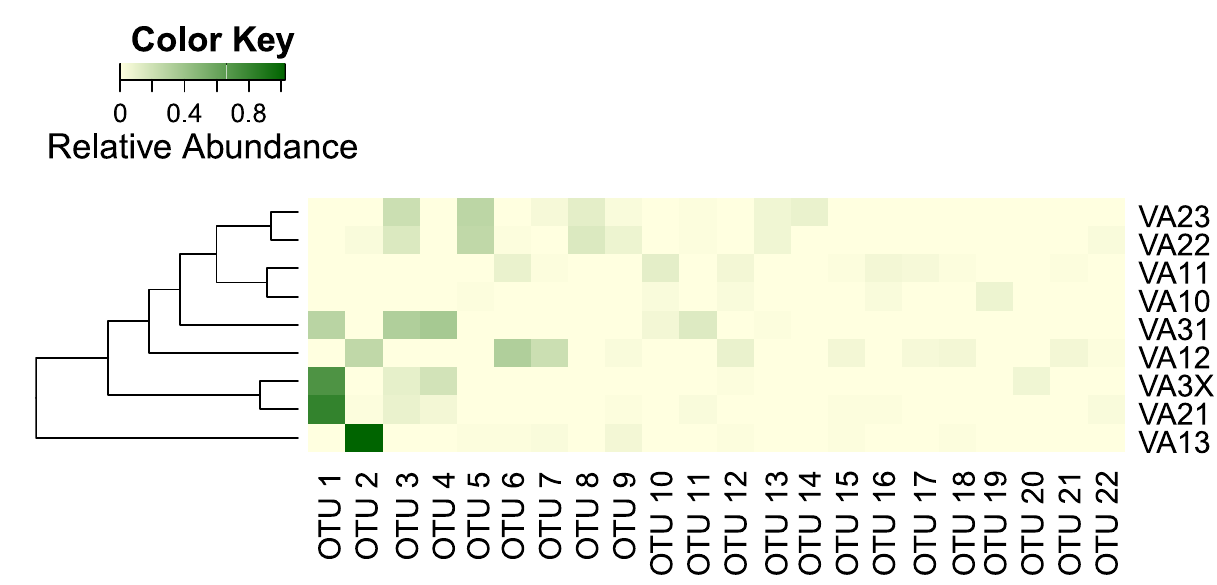
Fig 5. Heat map showing distribution and abundance of 22 dominant OTUs in eight reservoirs and one adjacent